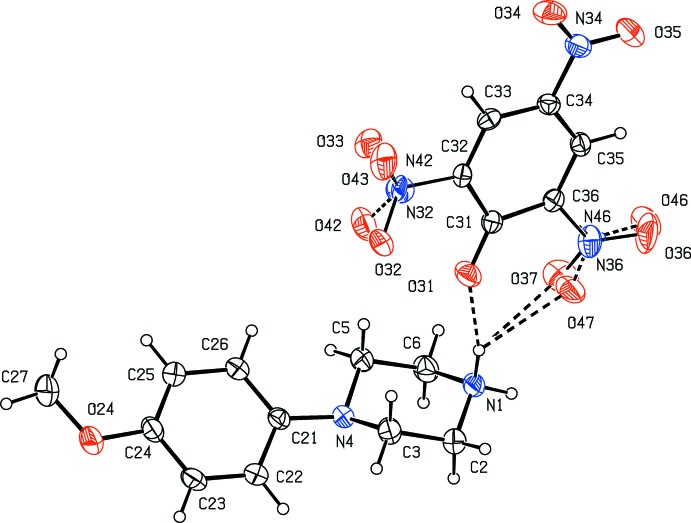
The independent components of compound (III) showing the atom-labelling scheme, the hydrogen bonds, drawn as dashed lines, within the selected asymmetric unit, and the disorder in the nitro groups: the major disorder components are drawn with full lines and the minor disorder components are drawn with broken lines. Displacement ellipsoids are drawn at the 30% probability level.